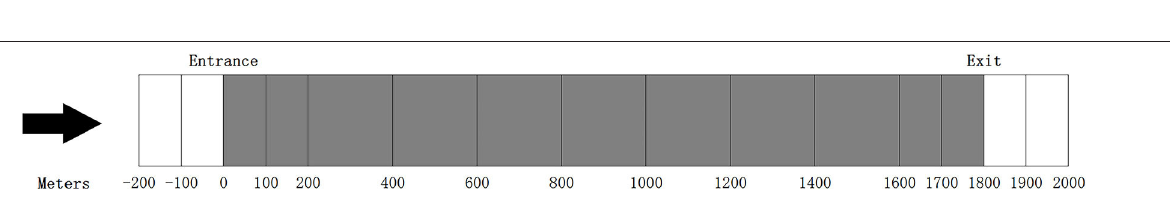
FIGURE 2 | Schematic diagram of the experimental highway